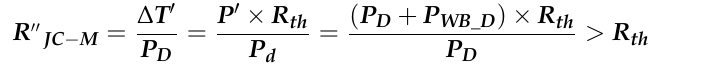
Figure 18. Power dissipation of IGBT module using Kelvin setup.